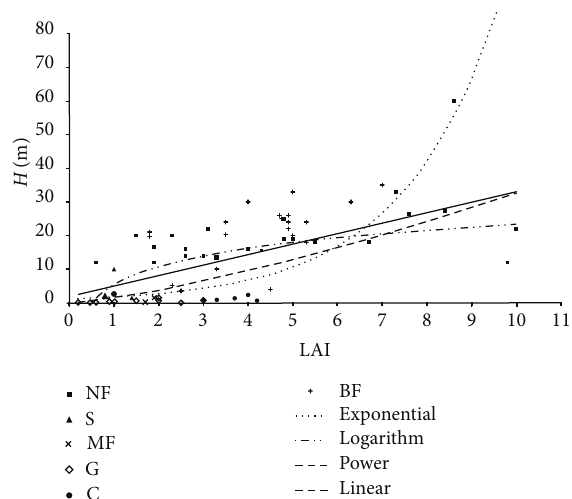
Figure 2: Result of fitting curve of 𝐻 and LAI BF (broadleaf forest), NF (needleleaf forest), C (croplands), G (grasslands), S (savannas), and (MF)